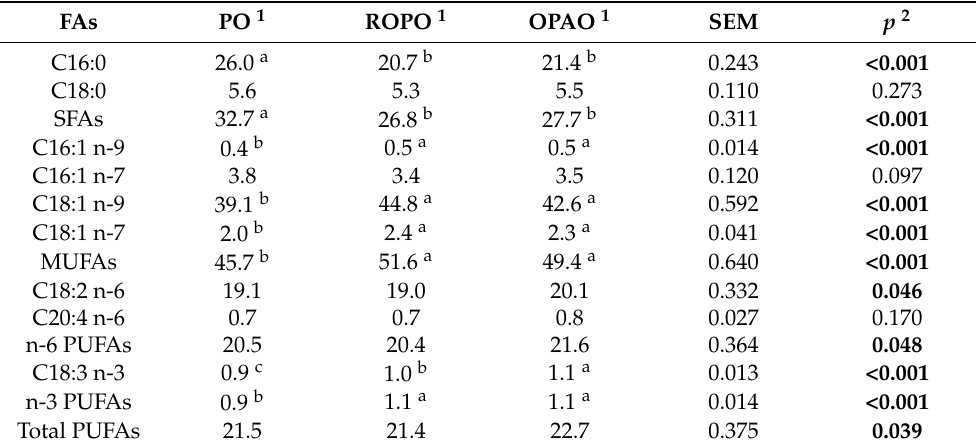
Table 4. Fatty acid profile (%) of fresh dark chicken meat with skin coming from the three experimental diets.